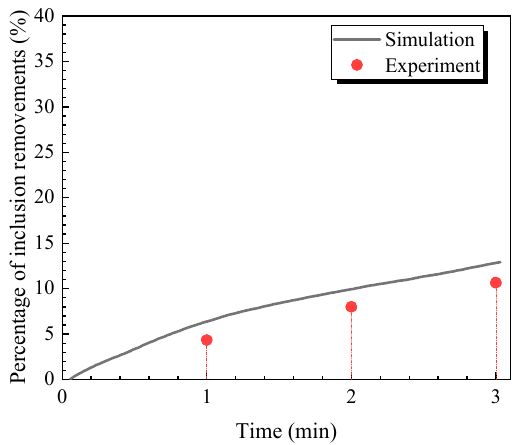
Figure 3. Comparison of inclusion removements in water model through simulation and experi ‐ ment.